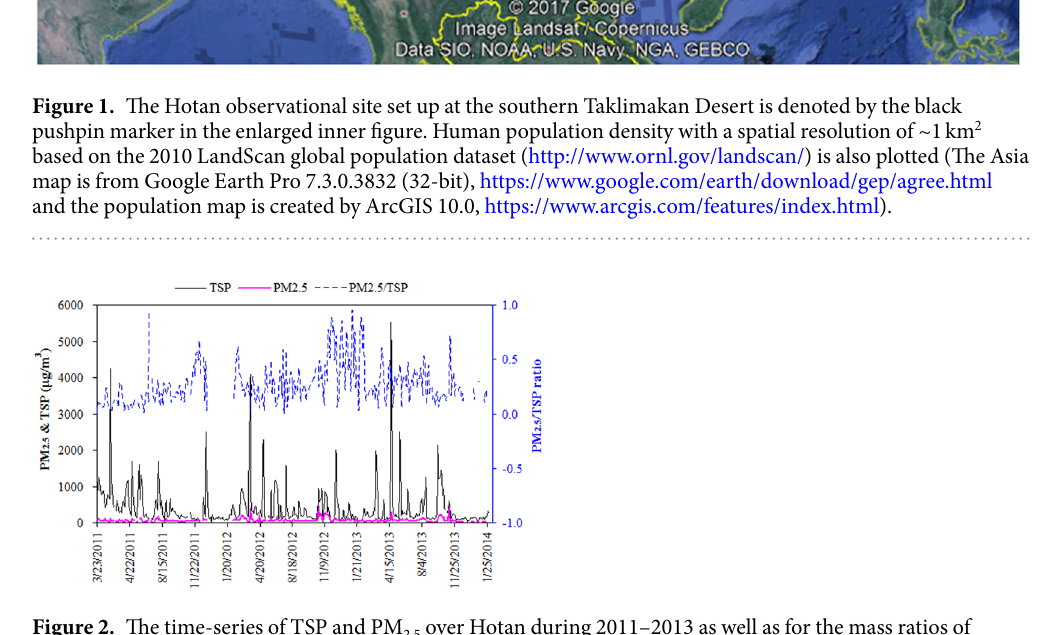
Figure 2. The time-series of TSP and PM 2.5 over Hotan during 2011–2013 as well as for the mass ratios of PM 2.5